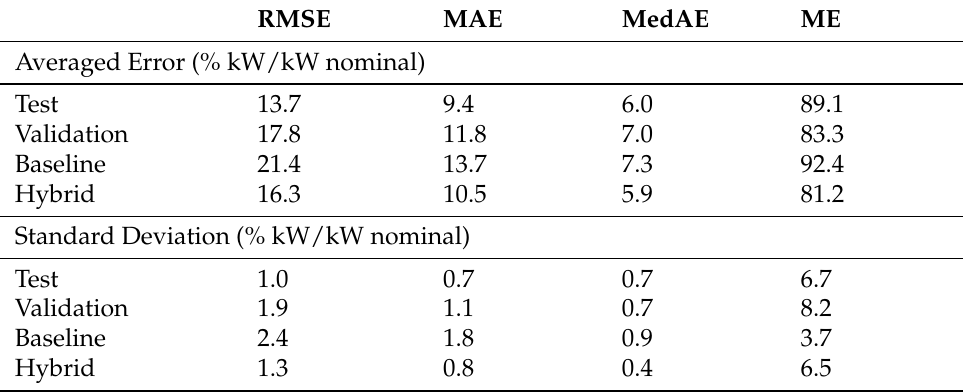
Table 3. Summary of the metrics averaged over the 16 turbines for the three considered models. For the direct power prediction with an ANN, results from both test set and validation set are included, whereas for the other two only the validation set is